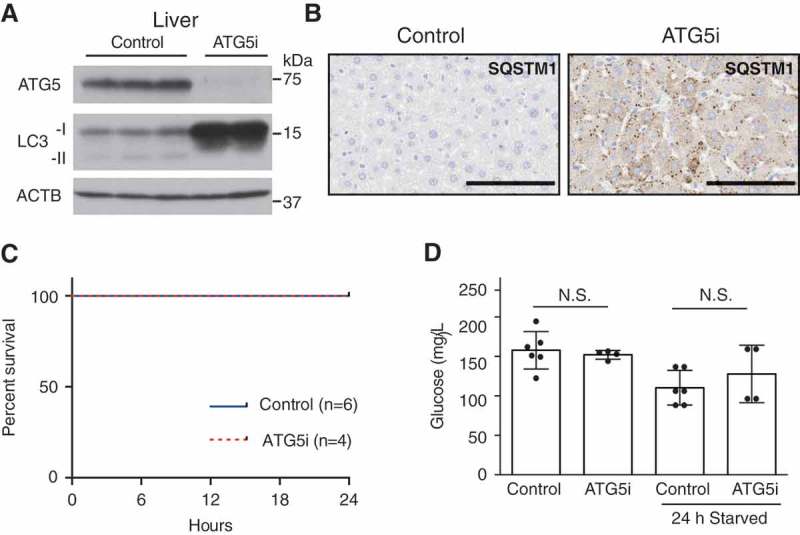
Adult ATG5i mice survive starvation-induced stress and maintain glucose homeostasis. (a) ATG5i mice administered dox for 2 weeks and having food withdrawn for 24 h prior to sacrifice display downregulation of ATG5 and a reduction of LC3-I to LC3-II conversion in the liver. (b) These same livers also show the formation of SQSTM1 aggregates as seen through immunohistochemical analysis. Scale bars: 100 μm. (c) These mice show no evidence of starvation-induced mortality when food is removed for 24 h (control, n = 6; ATG5i, n = 4). (d) Blood glucose levels before and after food withdrawal show no significant difference between control and experimental (free feeding P = 0.66; starved P = 0.37, Mann Whitney). N.S., not significant.